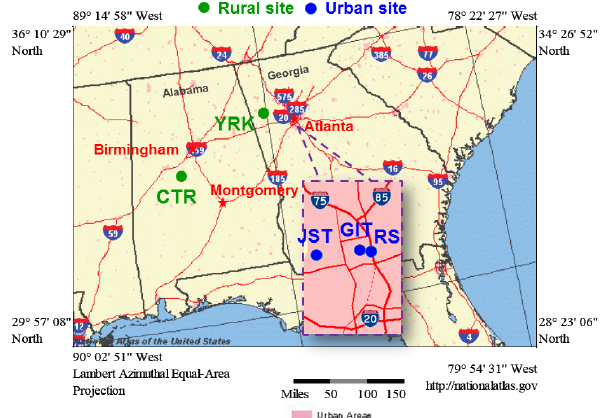
Figure 1. Sampling sites in the southeastern USA, consisting of two rural and three urban